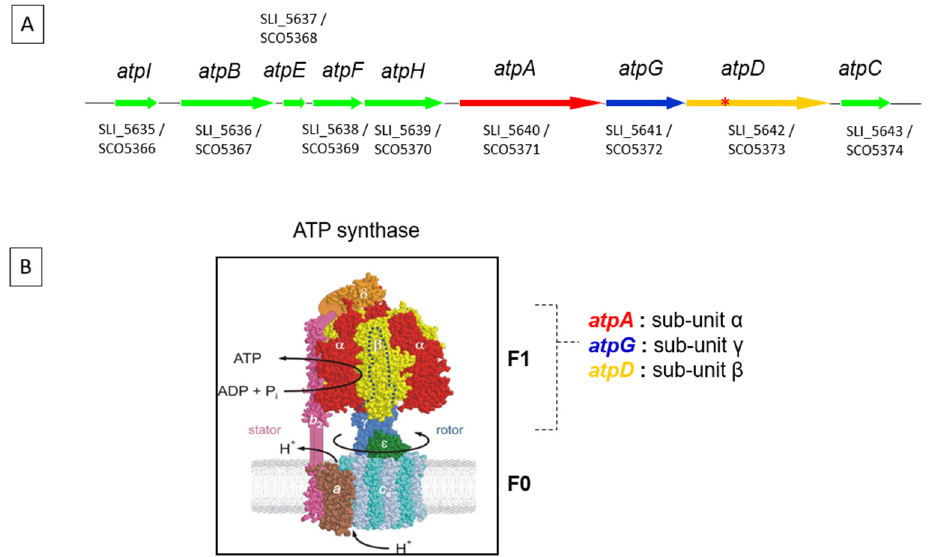
Figure 1. ( A ) Cluster of genes directing the synthesis of the ATP synthase sub-units of Streptomyces lividans . The red asterisk (*) in atpD indicates the 12 amino acids deletion of the active site of this sub-unit. ( B ) Schematic representation of the F0 and F1 part of the ATP synthase of S. lividans. When uncoupled from the membranous F0 part, the F1 part of the ATP synthase catalyzes the degradation of ATP (ATPase